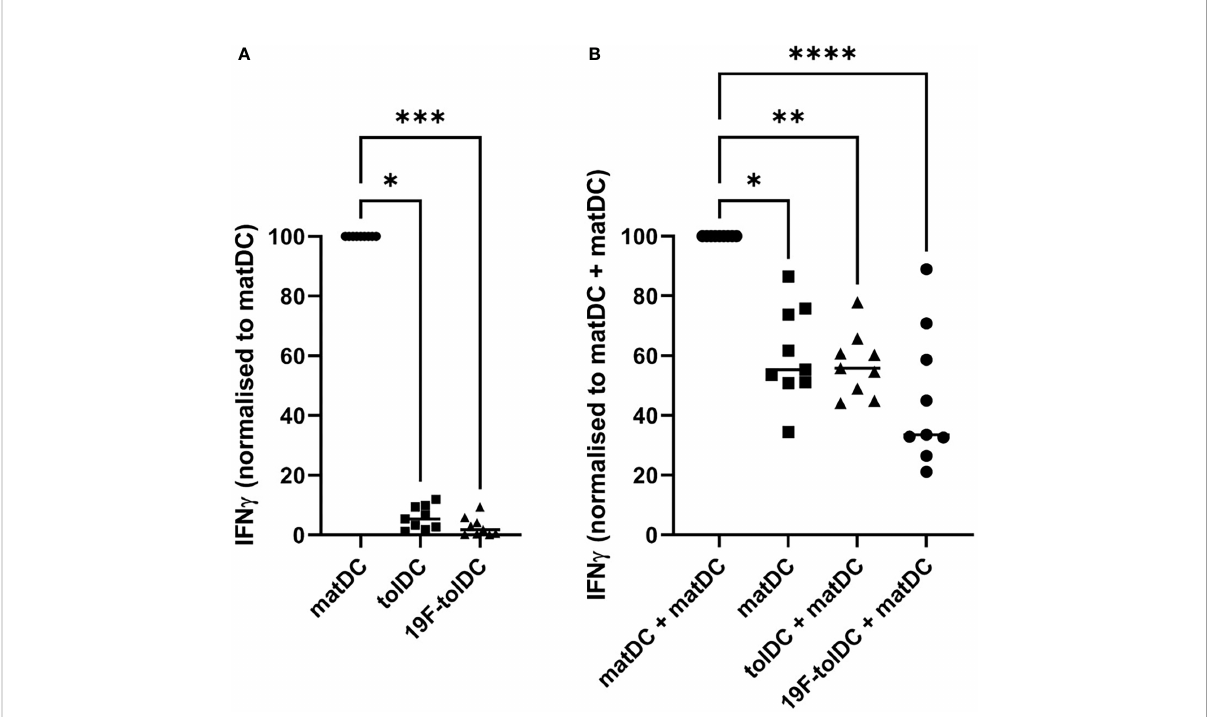
FIGURE 4 Comparison of IFN g induction by tolDC and 19 F-tolDC in allogeneic PBMC. Frozen PBMC gathered from 4 different donors allogeneic to the DC donor were thawed, counted and plated out at 10 5 cells per well in a 96-well plate. Individual and combinations of fresh DC were added at 10 4 per condition. Supernatants were collected after 4 days. Levels of IFN g were determined by ELISA. (A) Values were normalised by dividing the IFN g values for the tolDC and 19 F-tolDC by the value for matDC then multiplying by 100. (B) Co-cultures of various DC combinations and allogeneic PBMC. Values were normalised by dividing the values for matDC, tolDC + matDC and 19 F-tolDC + matDC by the value for matDC + matDC then multiplying by 100. Graphs contain paired experiments with the median value represented by a line (*p ≤ 0.05, **p ≤ 0.01,***p ≤ 0.001, ****p ≤ 0.0001). Supernatants from PBMC alone controls were included in these experiments in which very low to undetectable levels of IFN g were